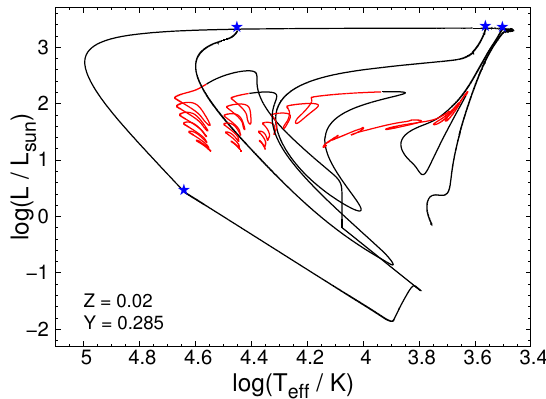
Figure 1. H-R diagram of four of the evolutionary sequences studied corresponding to initial chemical compositions of Z = 0.02 and Y = 0.285. The subflashes phase is plotted with red lines. Blue stars on each track mark the onset of core helium